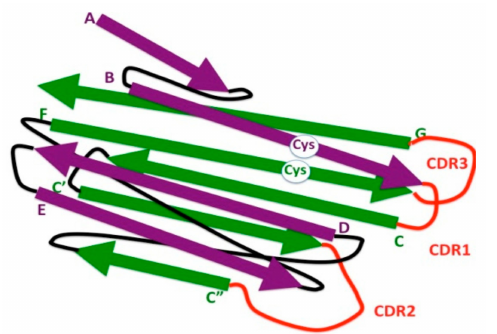
Figure 2. Schematic representation of 3-D strand topology in the eukaryotic IgV domain. Antiparallel strands of the two β sheets are colored in purple and green, respectively, and identified by letters. Connecting loops are depicted in black. Loops bearing the complementary determining regions (CDR1, CDR2, and CDR3) are depicted in red. The highly conserved cysteine residues (Cys) involved in the formation of the disulfide bond between the β strands B and F are indicated (white